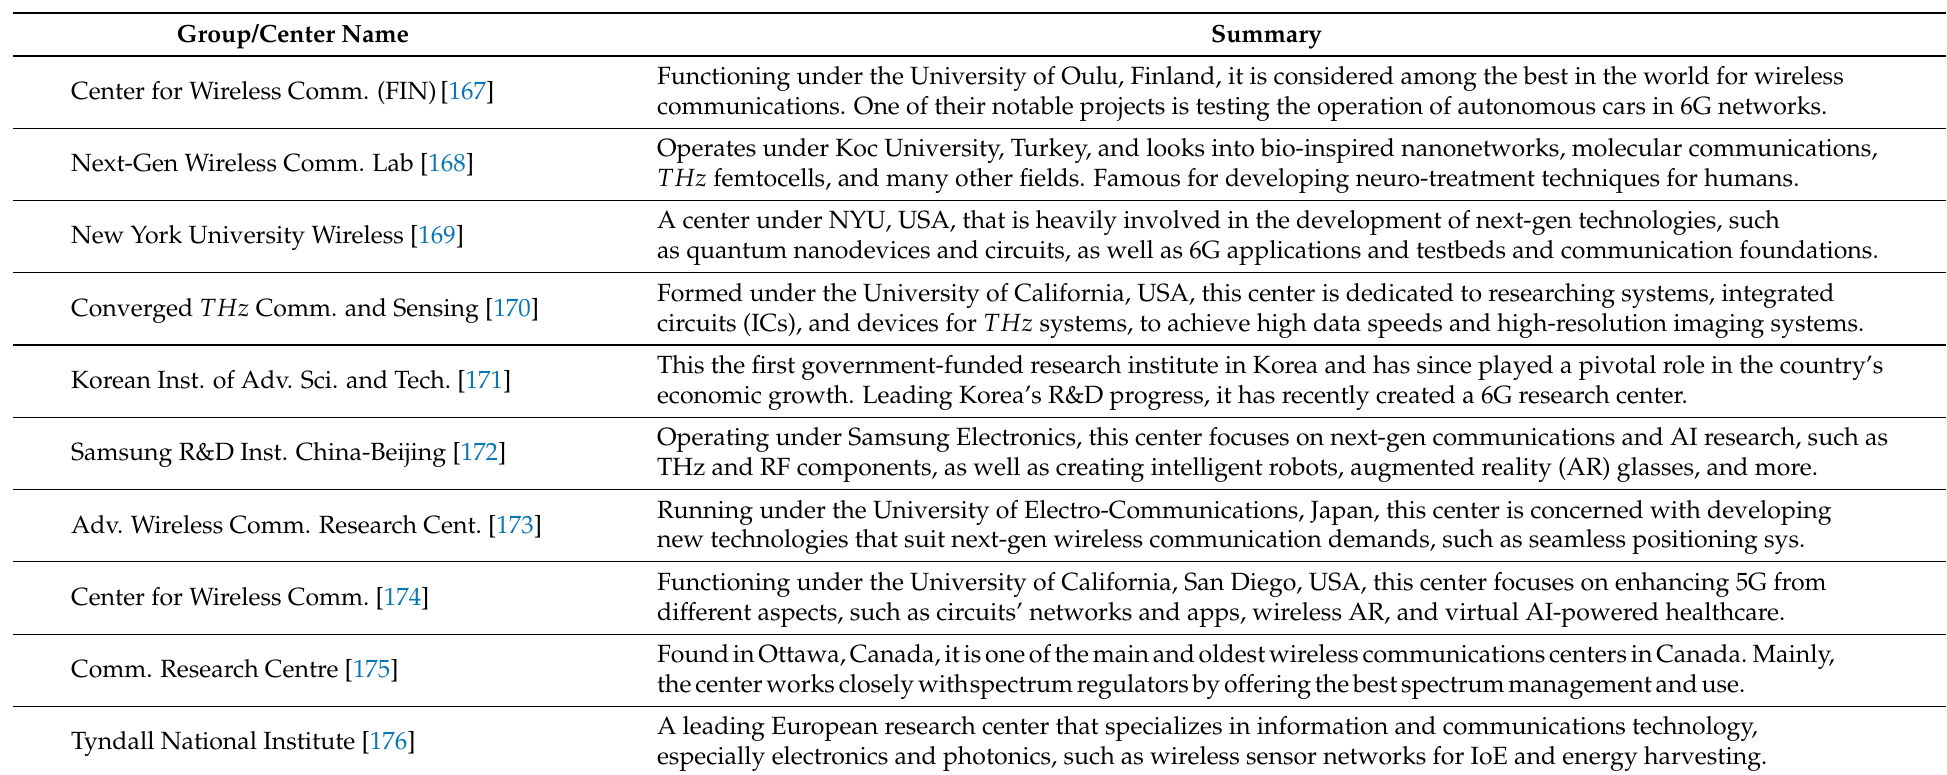
Table 6. A brief preview of some of the biggest research group/centers that are interested in B5G/6G